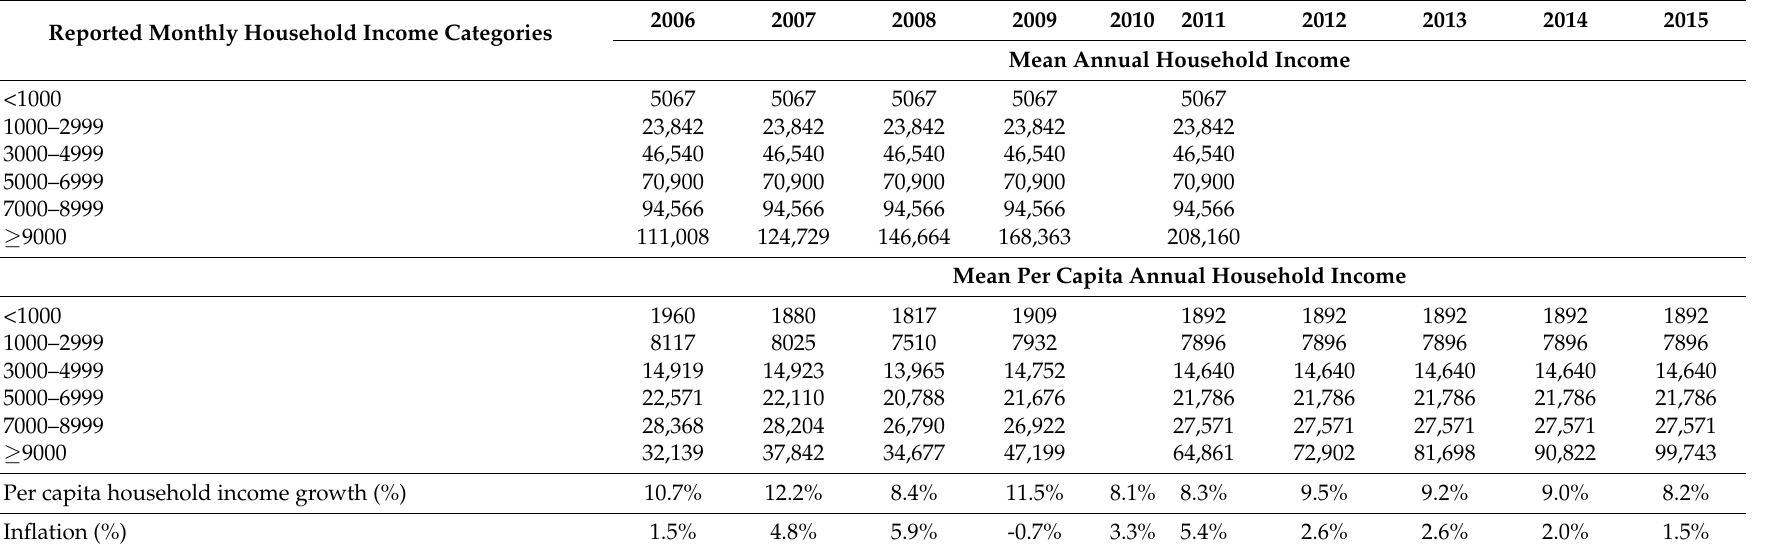
Table A1. Per capita annual household income by monthly household income categories reported in ITC China